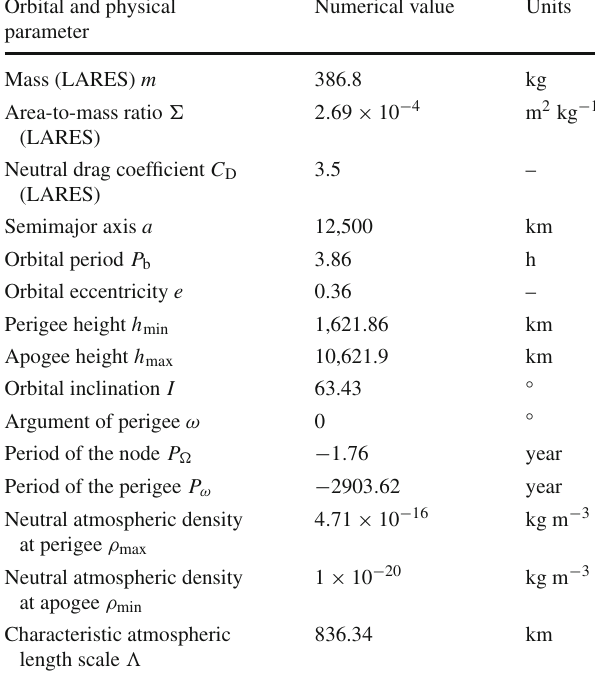
Table 1 Orbital and physical configuration of a fictitious terrestrial geodetic satellite. Since it is ρ LARES = 5 . 96 × 10 − 16 kg m − 3 [16], and ρ LAGEOS = 6 . 579 × 10 − 18 kg m − 3 [14], we, first, used them